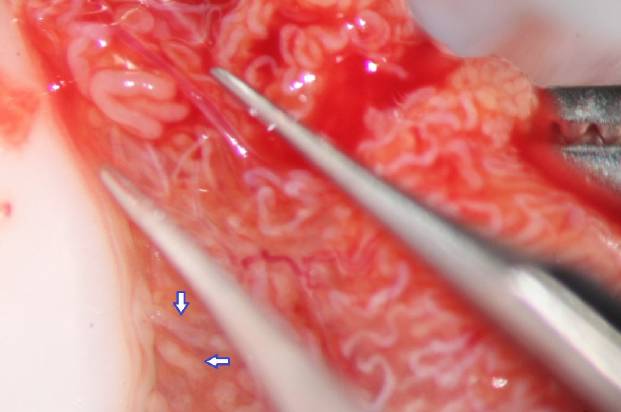
Figure 9. Sometimes dilated tubules appear bloated (between the forceps tips): see the contrast with the slightly less dilated tubules below (arrows).